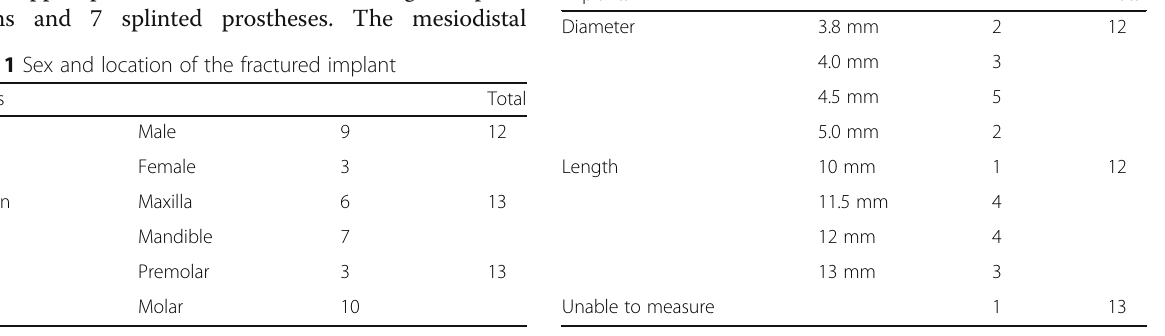
Table 2 Diameter and length of the implants